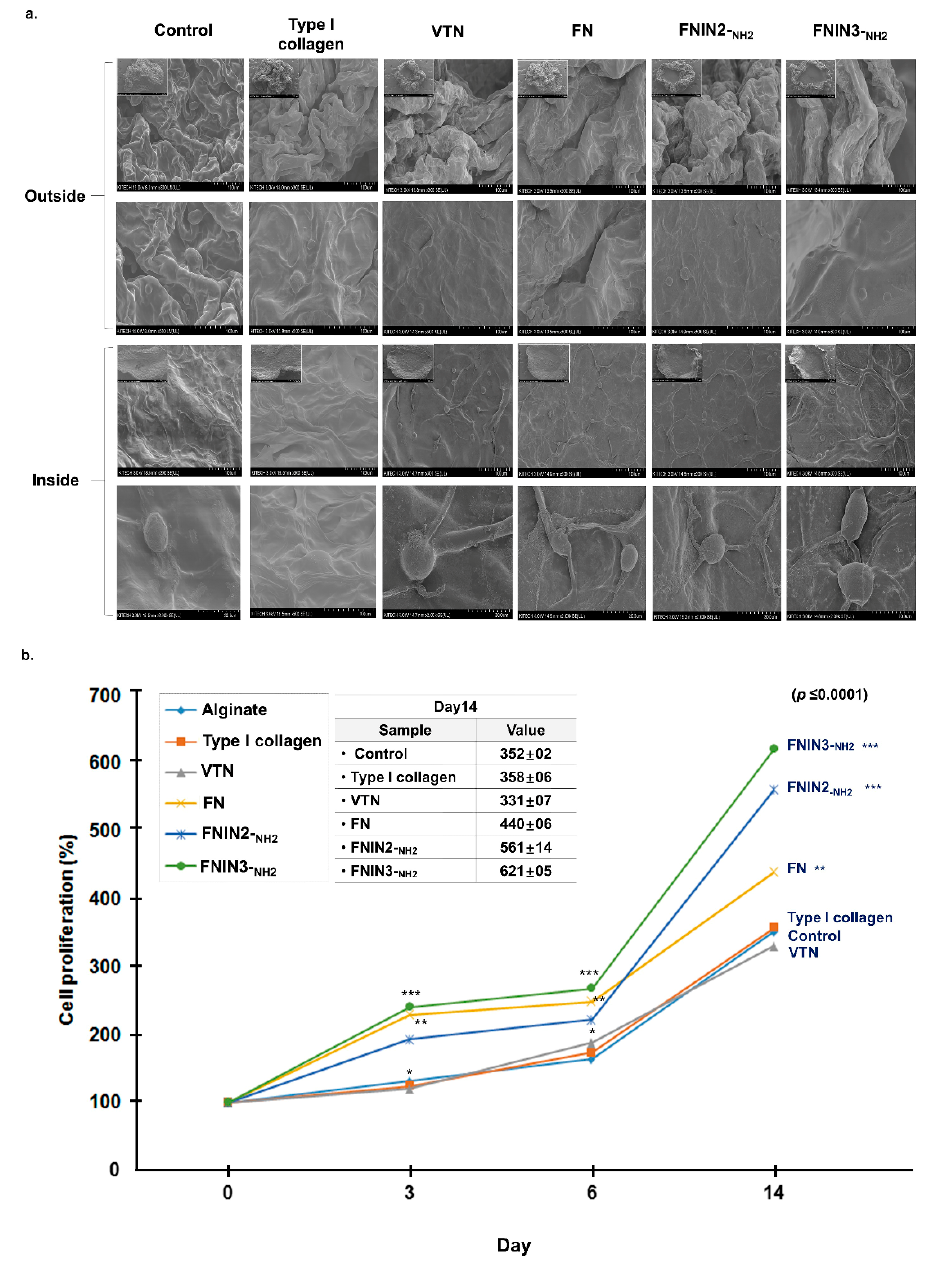
Figure 6. Analysis of cell proliferation in alginate beads containing FNIN2- NH2 or FNIN3- NH2 C2C12 cells were cultured for 0, 3, 6, or 14 days in collagen, VTN, FN, FNIN2- NH2 , or FNIN3- NH2 containing alginate beads. Cell morphologies inside beads were determined by SEM and cell numbers were counted using a hemocytometer. ( a ) SEM images of bead. ( b ) Cell proliferations (%) for different types of ECM and FNIN treatments at different time points. Means ± SD ( n > 3). * p ≤ 0.05, ** p ≤ 0.001, *** p ≤ 0.0001.